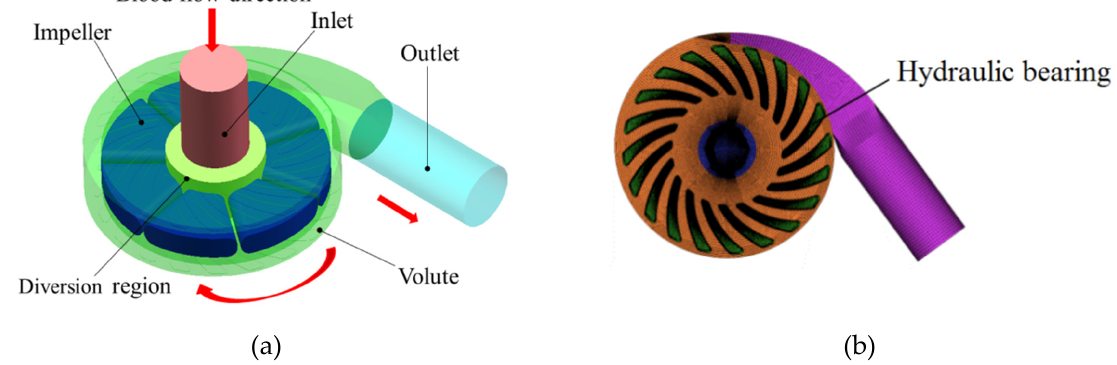
Figure 2. ( a ) Blood pump simulation model; ( b ) structured mesh of the blood pump, in which the area mesh of hydraulic bearing was refined.